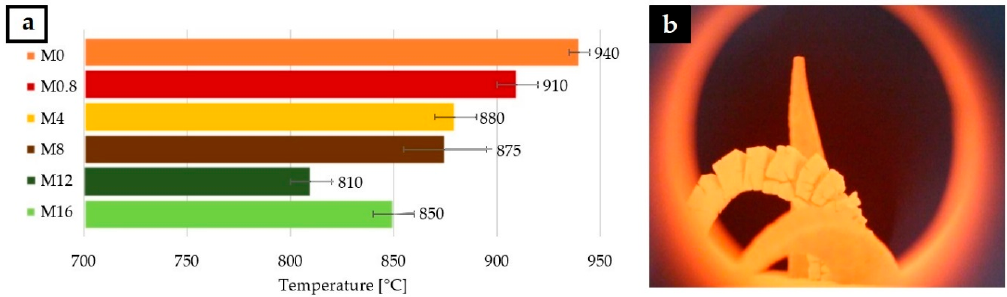
Figure 3. ( a ) Pyrometric refractoriness of six matrices with different content of boric acid and ( b ) tested matrix cone between two reference cones.